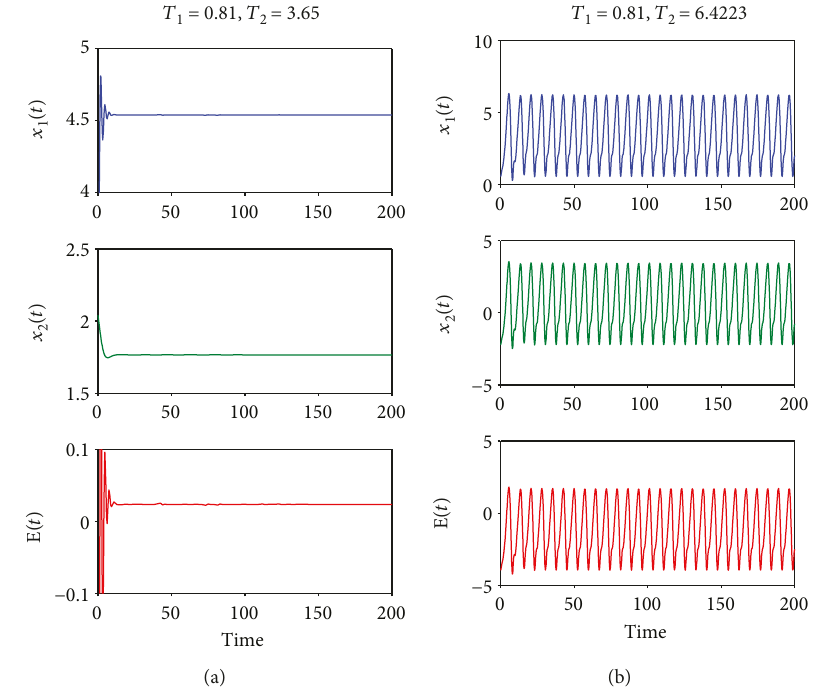
= 2 , b = 0 4 , a = 0 5 , k = 6 , q = 0 1 , m 1 1 1 u = 0 i = 1, 2 , dynamical responses of system (21) are plotted, where (a) τ 1 = 0 81 , τ 2 = 3 65 , and system i